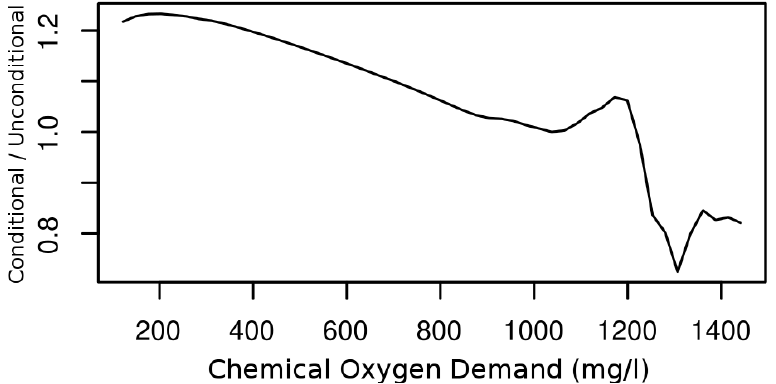
Figure 3. Partial regression plot of COD